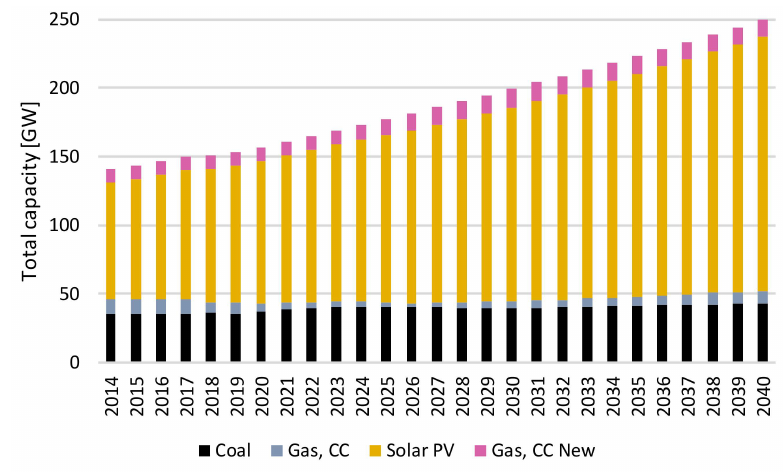
Figure 10. Total capacity (GW) in the RETarget scenario—with code